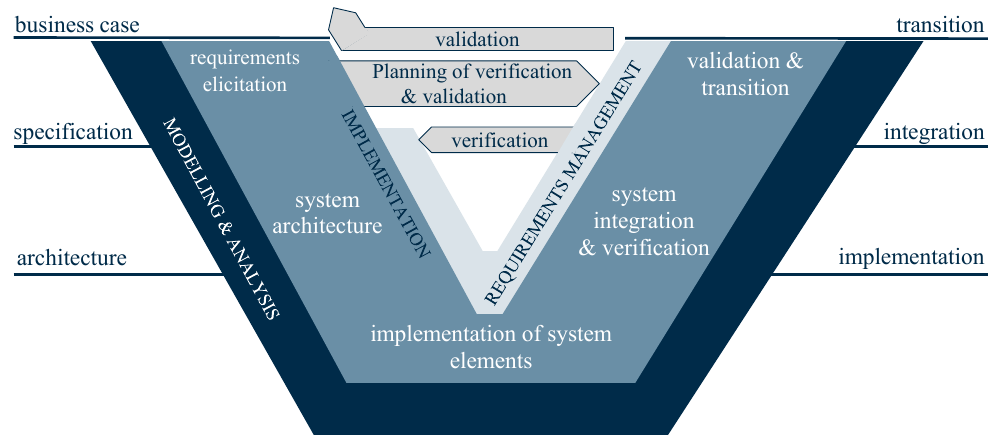
Figure 2. V-Model for development of mechatronic and CPSs